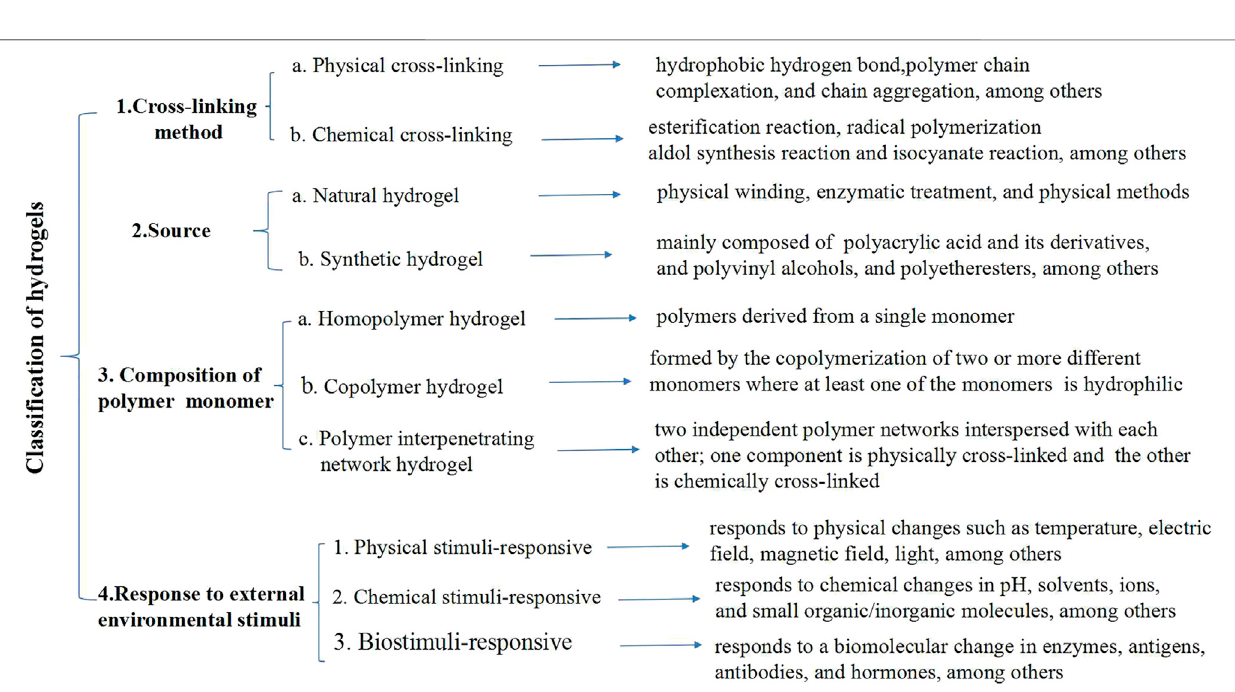
FIGURE 3 | Classi fi cation of